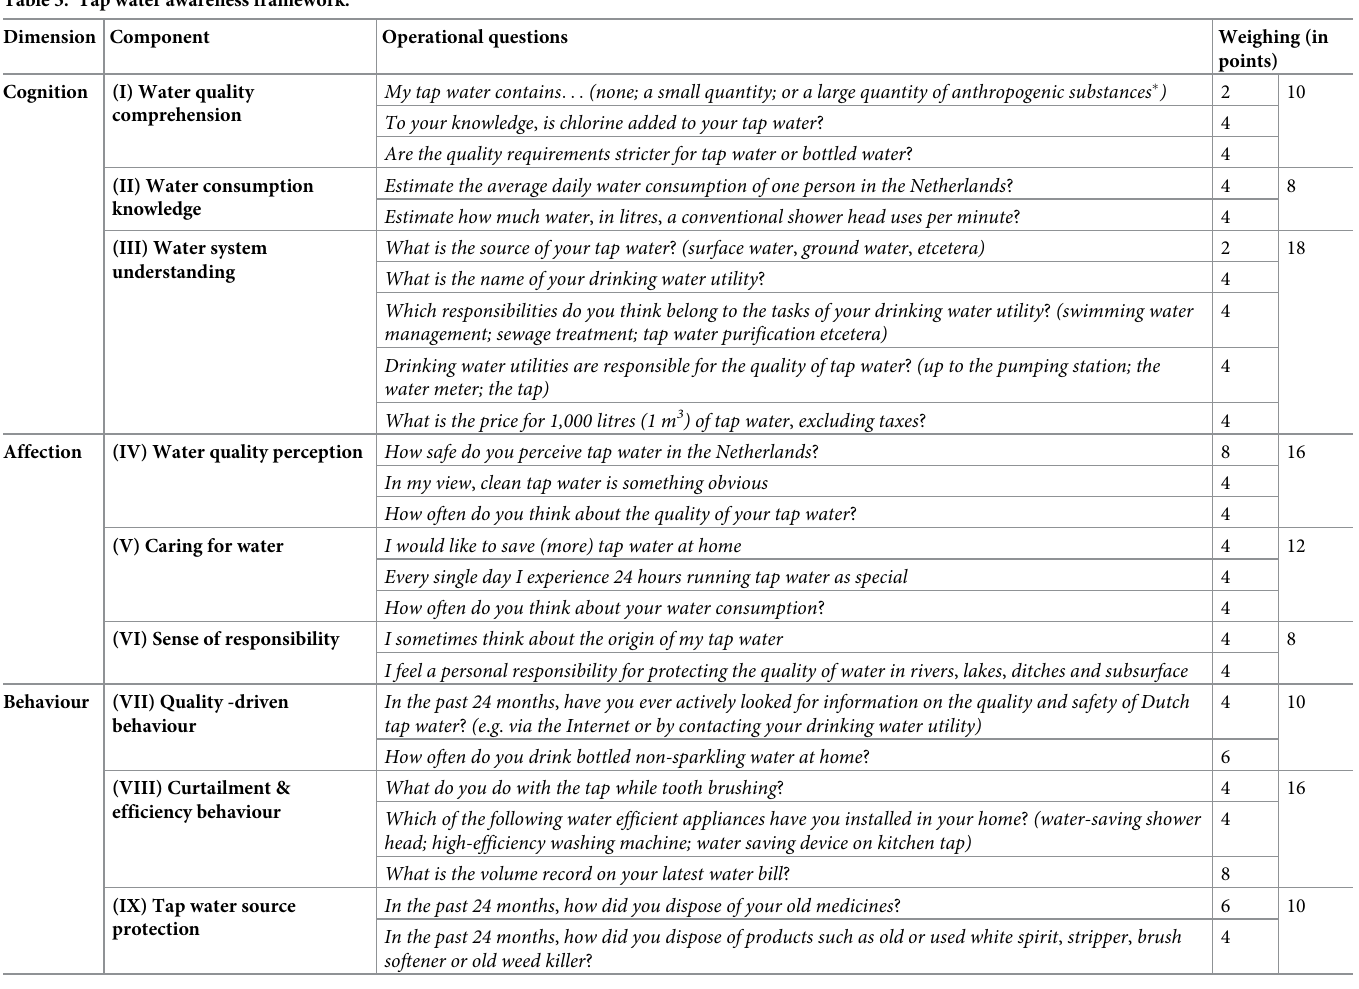
Table 3. Tap water awareness